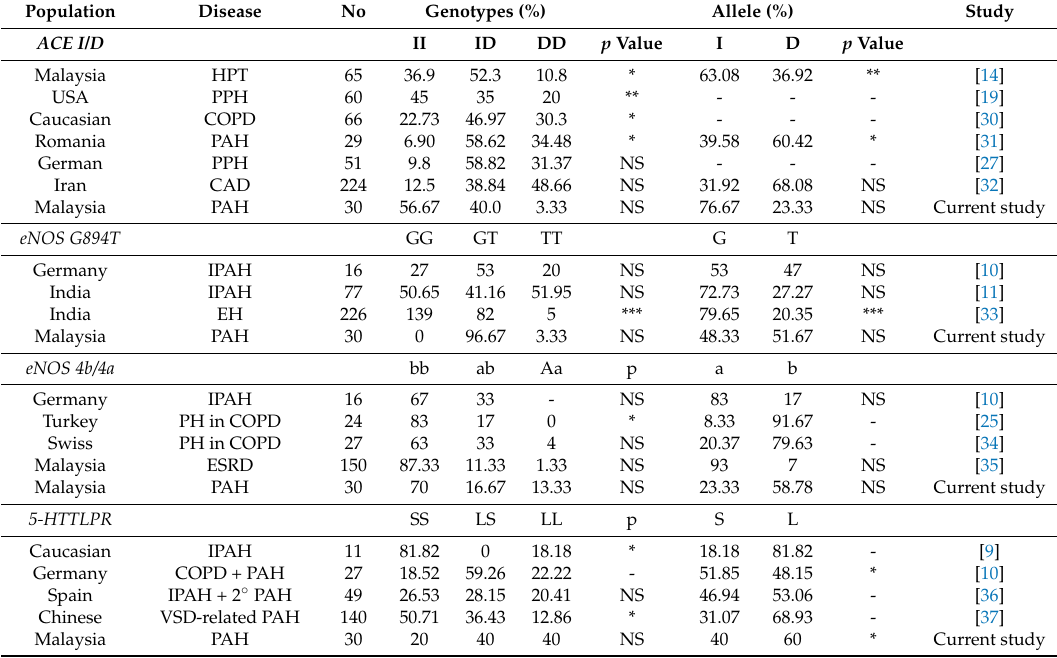
Table 5. Genotypes and allele frequency